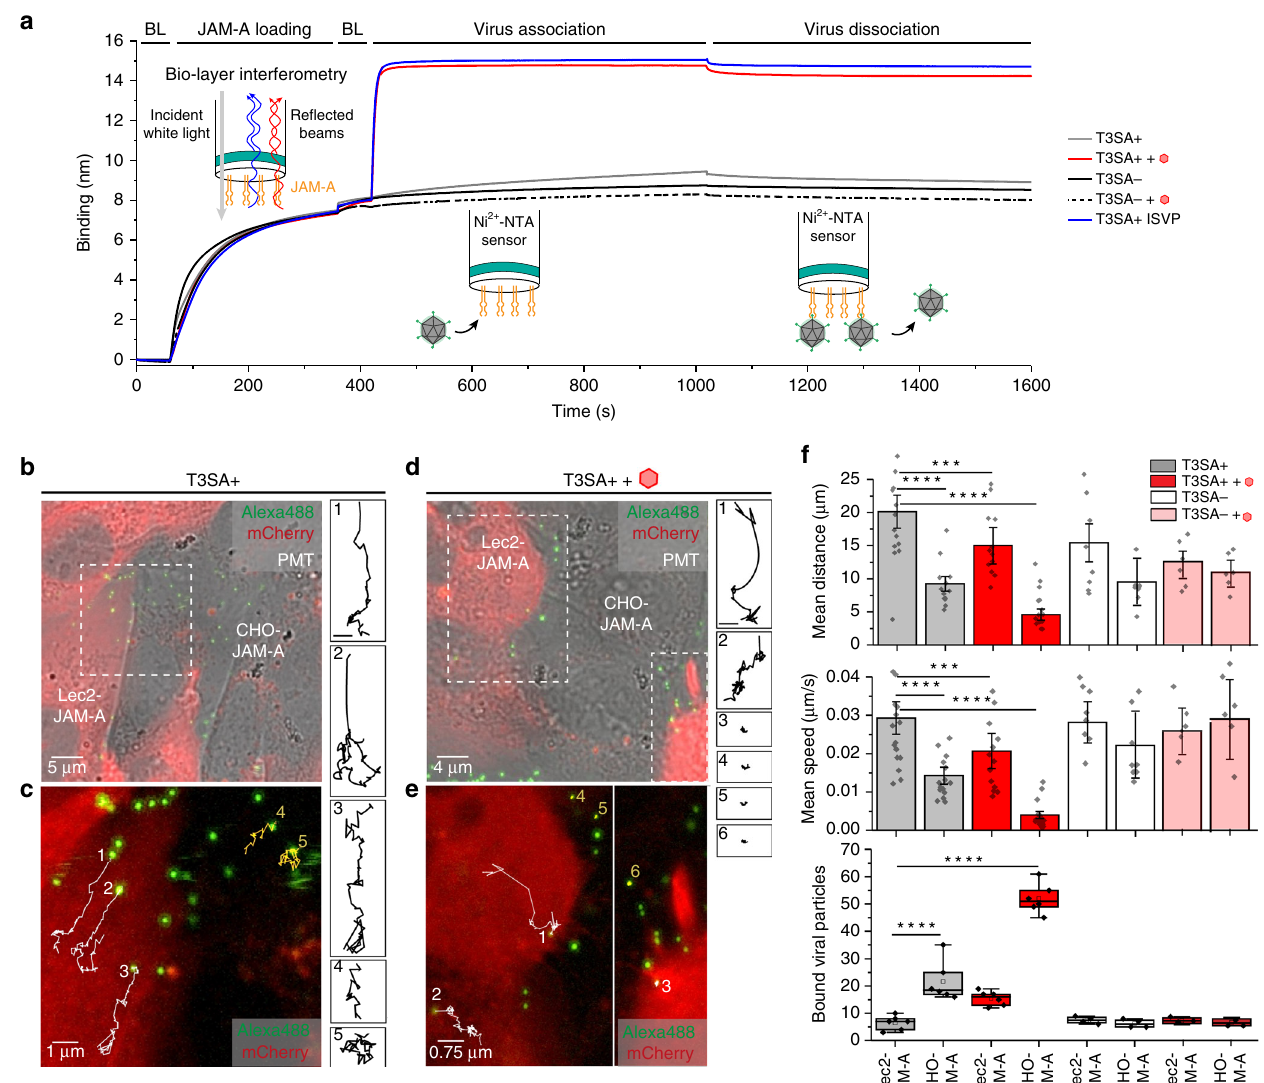
Fig. 8 Multivalent anchorage of virions alters diffusion potential and binding behavior. a Biolayer interferometry data for the binding of reovirus (T3SA − , T3SA + and T3SA + ISVP) to JAM-A receptor immobilized on NTA-coated biosensors. The effect of addition of 1 mM Neu5Ac in solution was tested for both T3SA − and T3SA + . Sensorgram starts with baseline (BL) measurement following by the immobilization of JAM-A to the NTA biosensor (loading), the addition of the virions (association), and fi nally by the dissociation phase. b – f Real-time confocal fl uorescence imaging of reovirus particles (labeled with Alexa Fluor 488 dye) incubated with co-cultured CHO-JAM-A and fl uorescently labeled Lec2-JAM-A cells in the absence ( b , c ) and presence ( d , e ) of 1 mM Neu5Ac. b , d Overlay images of Alexa Fluor 488 (virions), mCherry-actin (Lec2-Jam-A), and PMT signals. c , e Time-lapse trajectories of T3SA + particles. White and yellow trajectories represent the movement on Lec2-JAM-A cells and CHO-JAM-A cells, respectively. Magni fi cation of each trajectory is shown on the right side with the corresponding number (scale bar: 1 µ m). f Analysis of the mean travelled distance (top panel), mean travel speed (middle panel), and bound viral particles (bottom panel) for T3SA + binding in the absence (grey) or presence (red) of Neu5Ac as well as for T3SA − binding in the absence (white) or presence (light red) of Neu5Ac following adsorption to the cell mixture. The horizontal line within the box plot (bottom panel) indicates the median, boundaries of the box indicate the 25th and 75th percentile, and the whiskers indicate the highest and lowest values of the results. The square in the box indicates the mean. Data are representative of at least n = 3 independent experiments, with a minimum of n = 15 analyzed trajectories each. *** P < 0.001; **** P < 0.0001; determined by two-sample t -test in Origin. Error bars indicate s.d. of the mean value. Source data